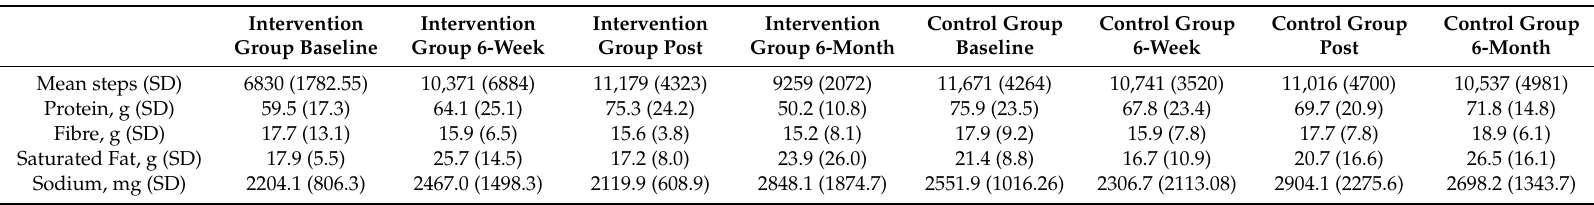
Table 3. Child Nutritional Variables and Step Count for Intervention and Control Groups, at Baseline, Mid-Intervention, Post-Intervention, and 6-Month Follow-Up. Intervention Group Baseline